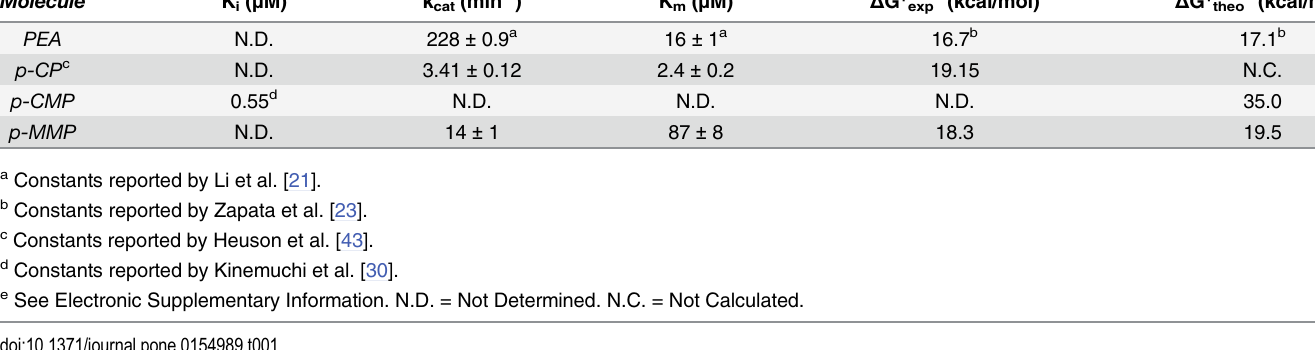
Table 1. p-CMP and p-MMP kinetic constants for MAO-B and experimental and calculated free Gibbs energy barriers.